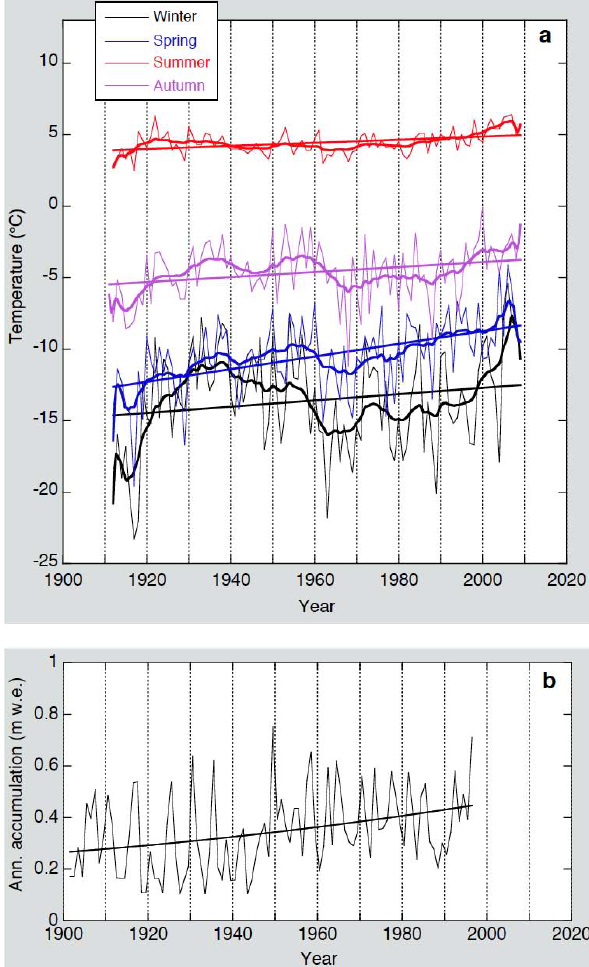
Fig. 5. (a) Homogeneous temperature series for the Isfjorden re- gion (Nørdli and Kohler, 2004; with additions provided by these authors). Low-pass filtered curves and linear fits are shown for each season. (b) Annual accumulation reconstructed from an ice core drilled at the Lomonosovfonna ridge (Pohjola et al., 2002). The fit is a second-order